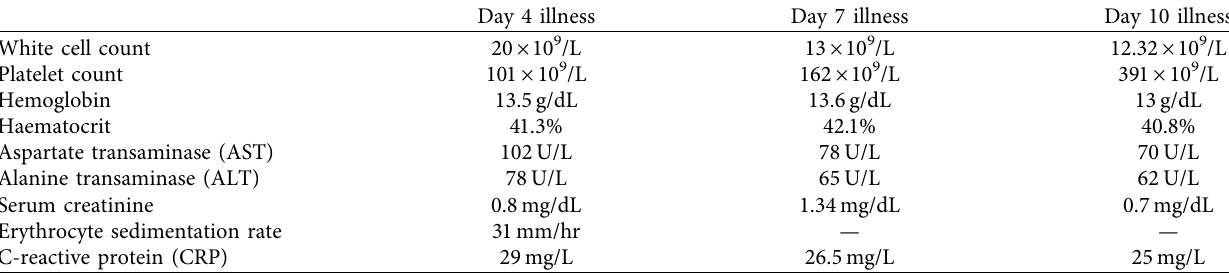
Figure 1: (a) CXR-PA taken on day 4 of illness (normal), (b) day 5 of illness (showing patchy opacities in peripheries of both lung fields), and (c) day 7 of illness Table 1: Laboratory investigations.